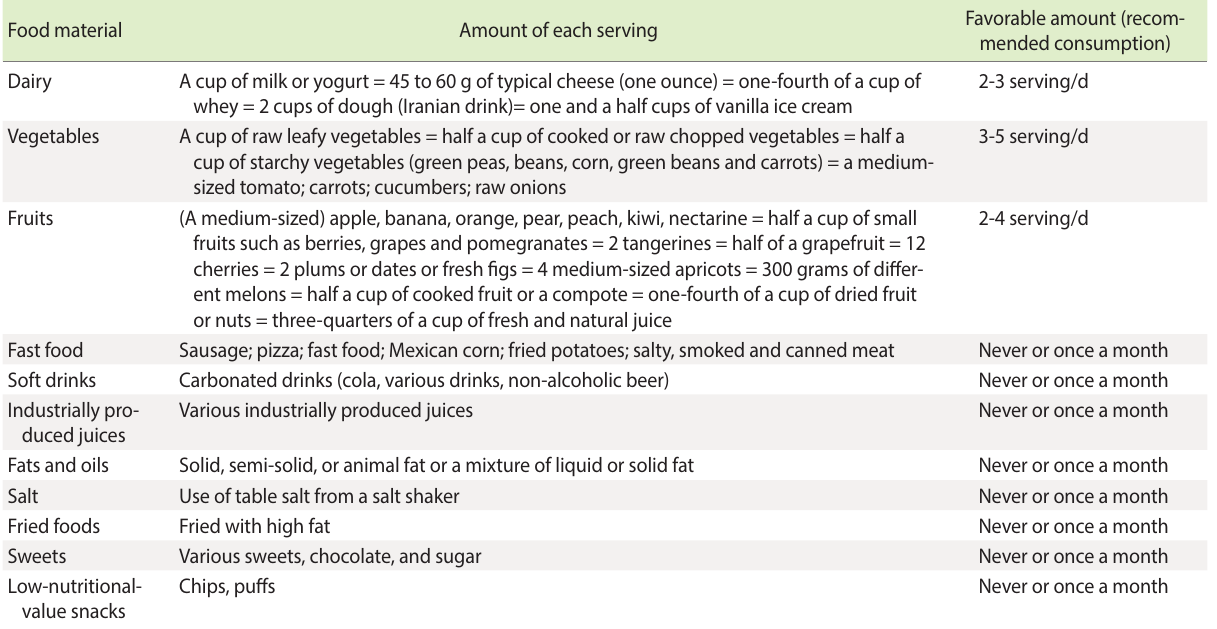
Table 1. Measurements of servings and definitions of favorable amounts of consumption of food materials Food material Amount of each serving